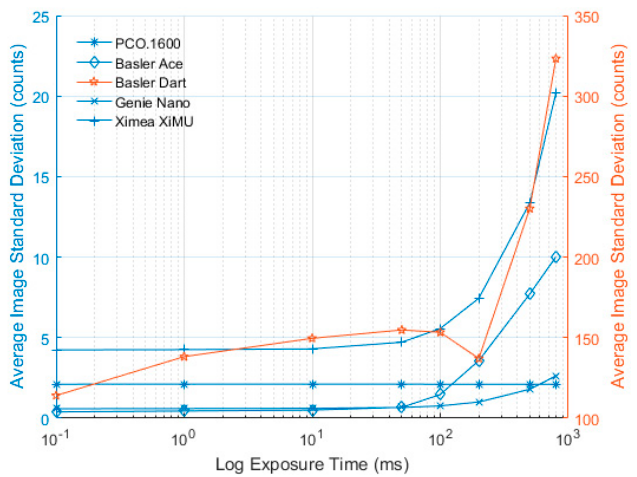
Figure 9. Image standard deviation vs. log exposure time for all cameras. PCO.1600, Basler Ace, Genie Nano and Ximea XiMU are plotted against the left y axis and Basler Dart is plotted against the right y axis.